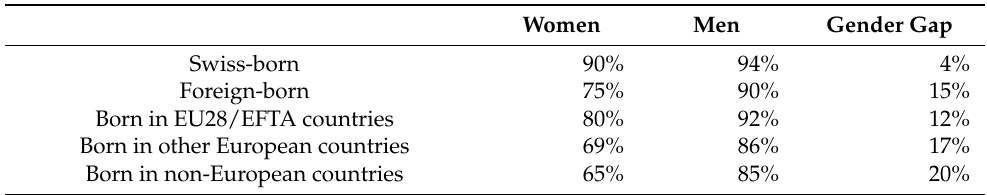
Table 1. Employment Rates of Highly Skilled Individuals in Switzerland by Gender and Country of Birth (15–60 years old),